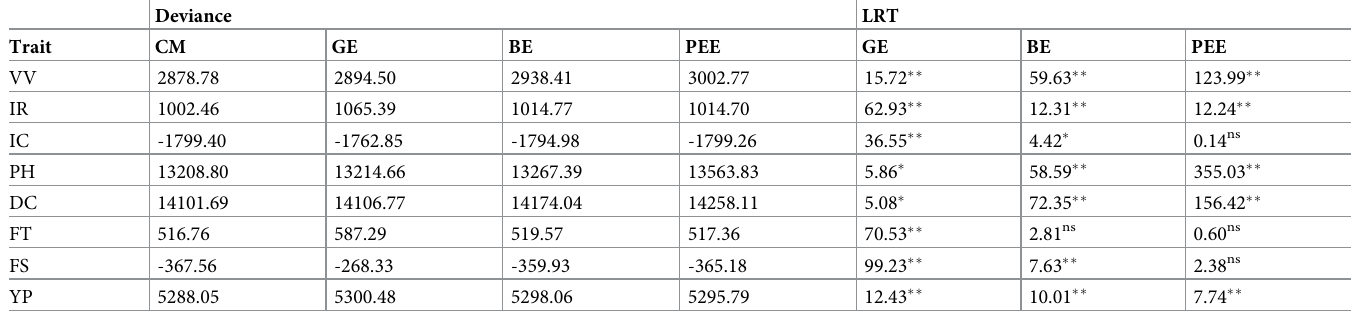
Table 1. Deviance and likelihood ratio test (LRT) for the following traits: Vegetative vigor (VV), incidence of rust (IR), incidence of cercosporiosis (IC), plant height (PH), canopy diameter (CD), fruit ripening time (FT), fruit size (FS), and yield per plant (YP), evaluated in the conilon coffee population. Deviance LRT Trait